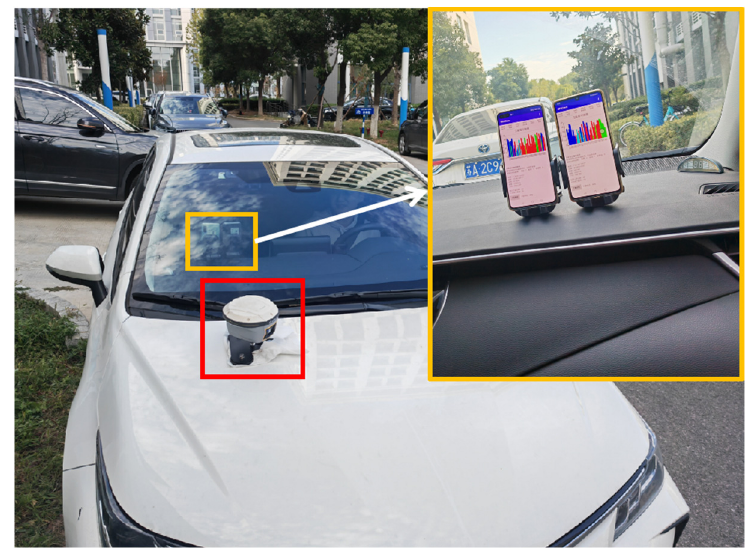
Figure 6. Equipment placement.